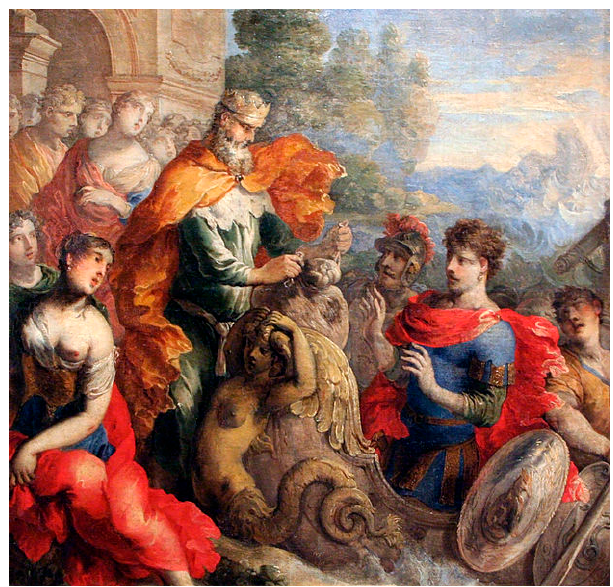
Figure 4. Aeolus Giving the Winds to Odysseus: Isaac Moillon, unknown date. Receiving a remarkable gift is of little value if it is not used appropriately.